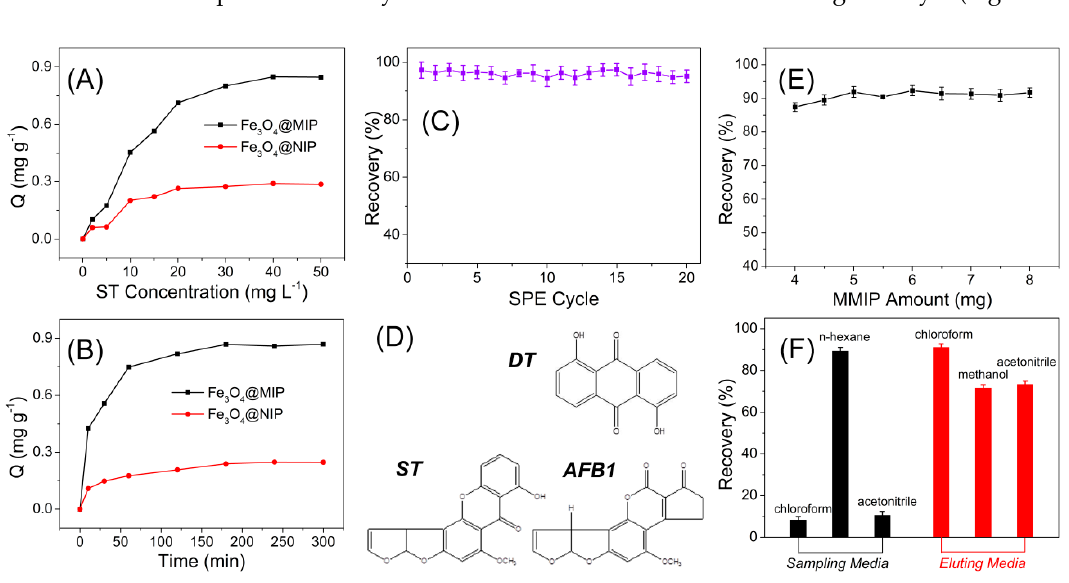
Figure 4. ( A ) Adsorption isotherms of Fe 3 O 4 @MIPs and Fe 3 O 4 @NIPs to ST; ( B ) kinetic uptake plot of Fe 3 O 4 @MIPs and Fe 3 O 4 @NIPs to ST; ( C ) evaluation of reusability of the mean squared prediction error (MSPE) column for ST analysis, with experimental conditions: 5 mg of polymers, 3 mL of ST methanol solution (20 mg·L − 1 for kinetic uptake; 2 to 50 mg·L − 1 for adsorption isotherms), 25 °C; ( D ) the structures of DT, ST and aflatoxin B1 (AFB1); ( E ) optimization of magnetic molecularly imprinted polymers (MMIP) amount for solid phase extraction (SPE); and ( F ) optimization of sampling media and eluting media for SPE. Table 1. Evaluation of adsorption isotherm by the Langmuir and Freundlich models, and data for pseudo-first-order and pseudo-second-order rate constant, experimental q e values, intra-particle diffusion rate constant, and Elovich parameters.